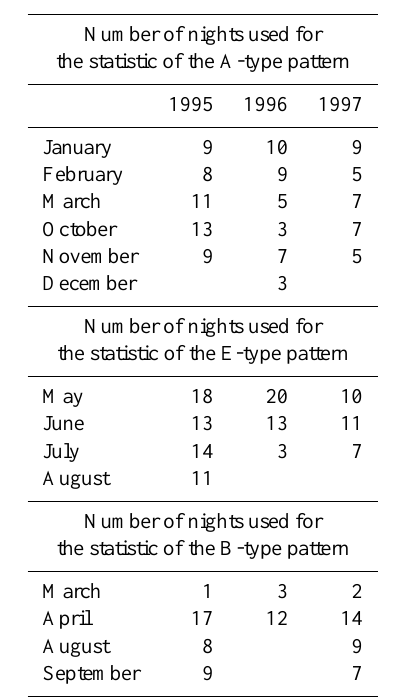
Table 3. Distribution of the nights used for the statistical study of the A-, E- and B-type patterns over the whole solar minimum period 1995–1997.